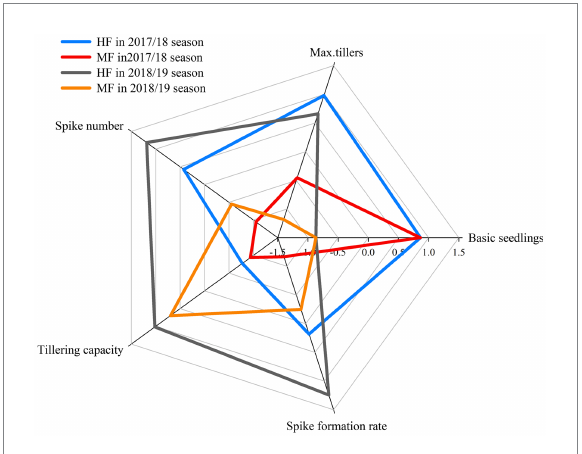
FIGURE 2 Comprehensive performance of basic seedlings, maximum tillers, spike number, tillering capacity, and spike formation rate of wheat in 2017/18 and 2018/19. HF, high soil fertility field and MF, middle soil fertility field. All data were